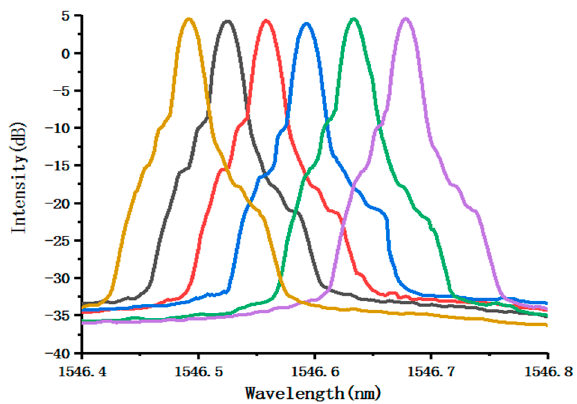
Figure 7. Fine tuning characteristics of the laser system from 1546.4–1546.8 nm with a tuning step of 0.036 nm.